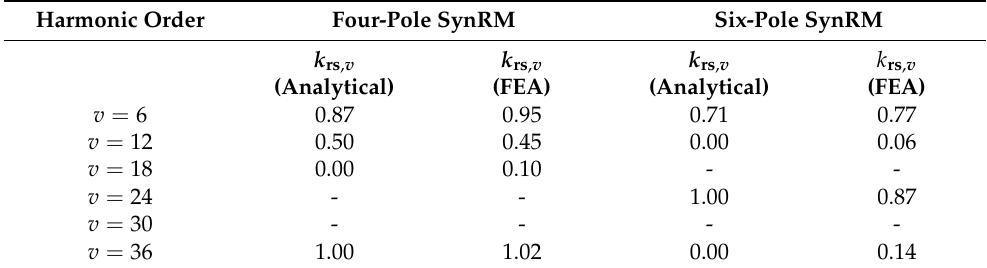
Table 3. Torque ripple harmonic component reduction as a result of two-step skewing. The 3D results were considered and relevant harmonic components analyzed.